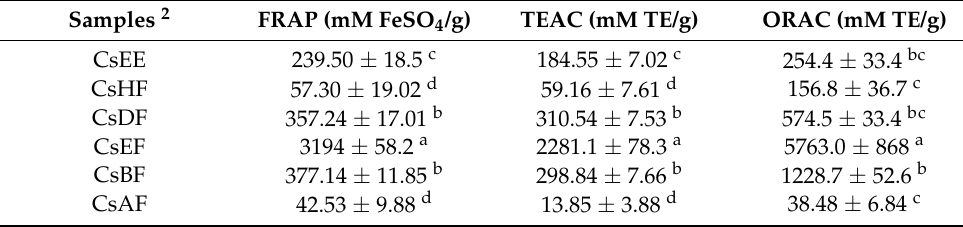
Table 2. FRAP, TEAC, and ORAC values of Calystegia soldenella extracts and fractions 1